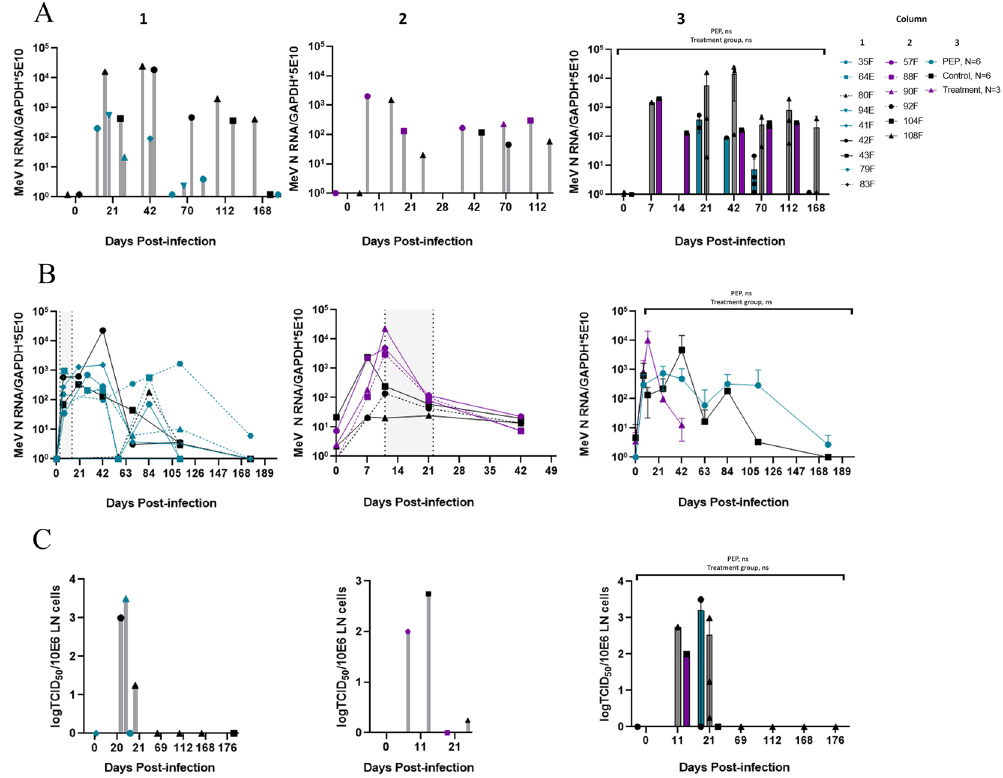
Figure 5. MeV N RNA in lymphoid tissue and bone marrow. MeV N RNA detected by RT-qPCR in RNA extracted from ( A ) 2 × 10 6 LN cells and ( B ) 2 × 10 6 BM cells. ( C ) Infectious virus measured by TCID 50 after co-cultivation of LN cells isolated from infected macaques. Column 1: Individual data from PEP study group and untreated controls; Column 2: Individual data from late treatment study group and untreated controls. Shaded area indicates treatment period. Column 3: Averaged data with pooled untreated control